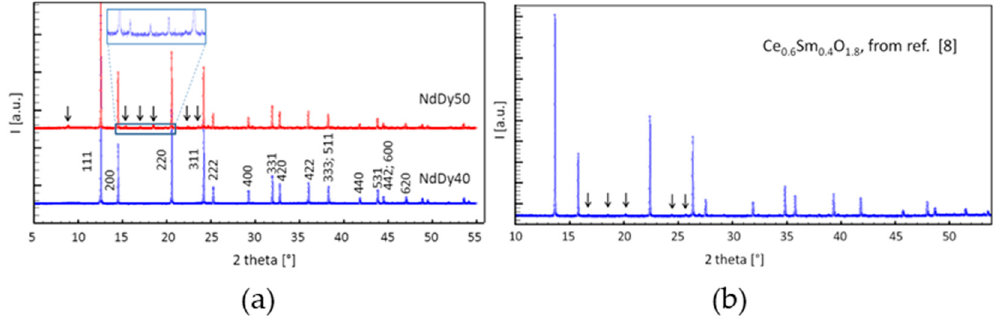
Figure 3. Di ff raction patterns of ( a ) NdDy40 and NdDy50 samples and ( b ) sample Ce 0.6 Sm 0.4 O 1.8 [8]. Arrows indicate the presence of superstructure peaks, with an enlarged view between 14 ◦ and 21 ◦ . In ( a ) Miller indices of peaks belonging to the F phase are reported within the di ff raction pattern of